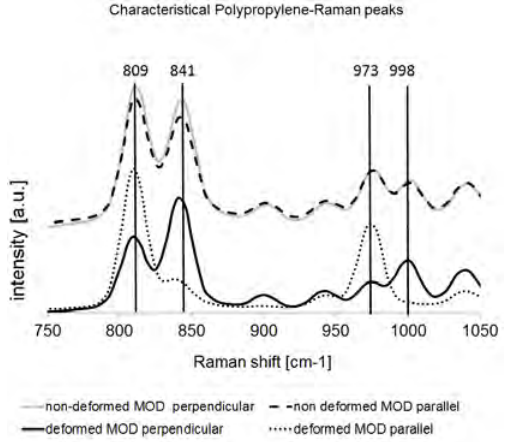
Figure 1. Material specific (PP) peaks for crys- tallinity and chain-orientation calculation.